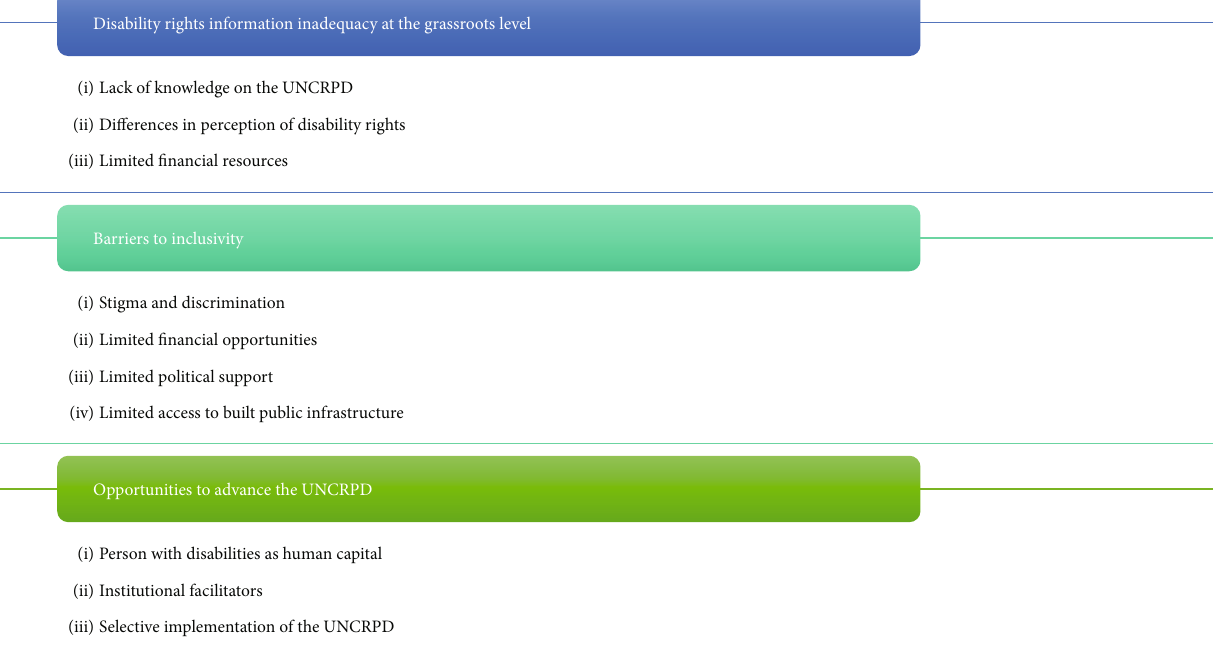
Figure 1: Themes and